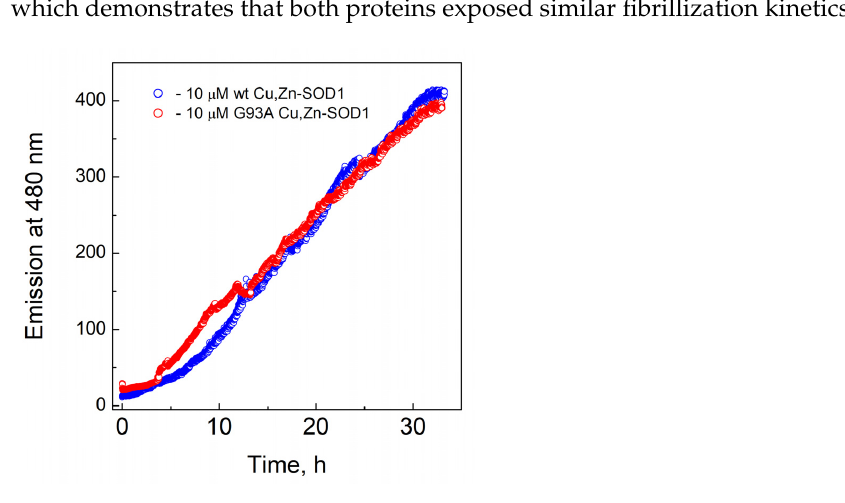
Figure 6. Fibrillization kinetics of Cu,Zn-SOD1. Conditions: 10 µM wt Cu,Zn-SOD1 (blue) and 10 µM of its G93A mutant (red) in 50 mM HEPES/50 mM NaCl, pH 7.3 at 40° C in the presence of 3.3 µM ThT.